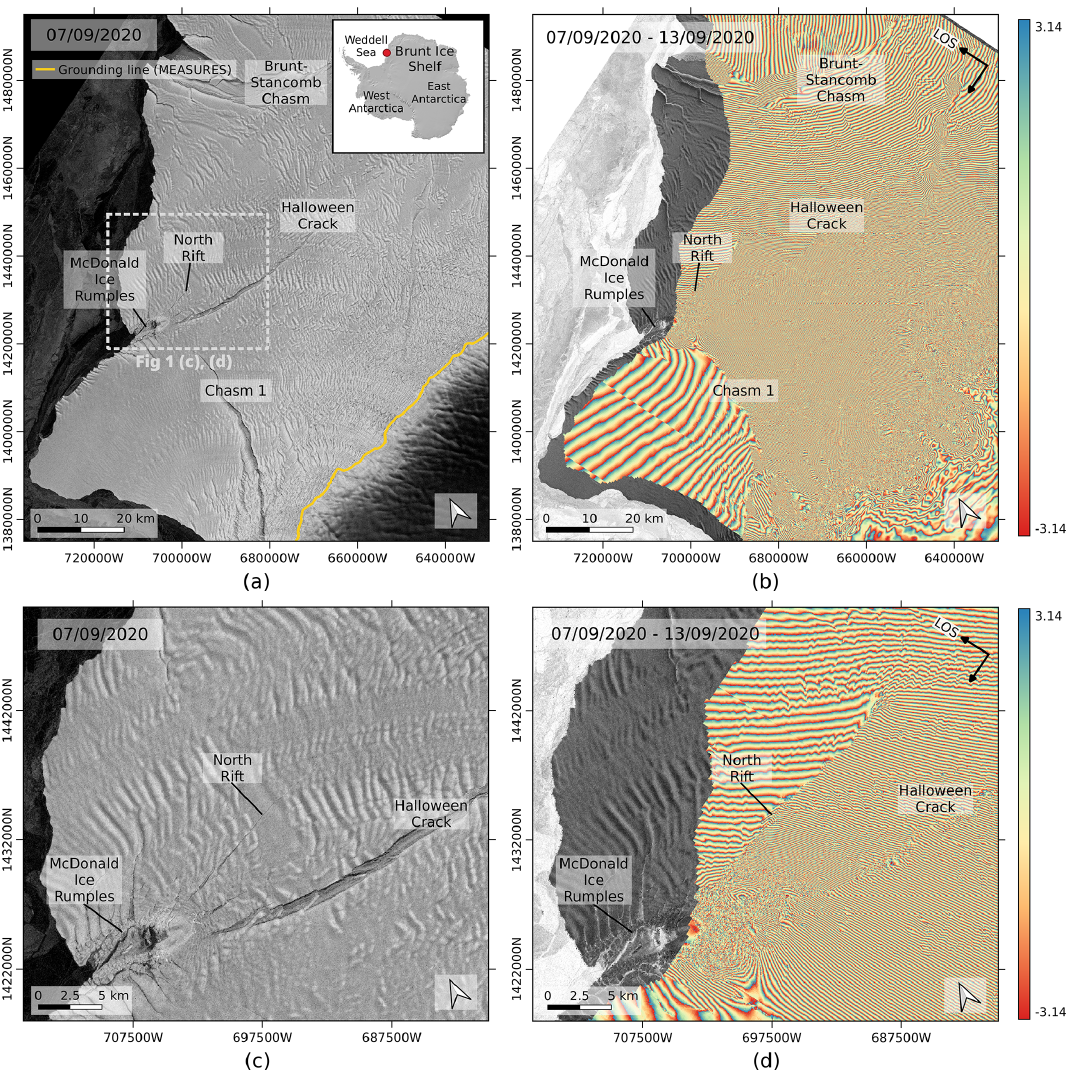
Figure 1. Rifting system on BIS. (a) Sentinel-1 brightness image acquired on 7 September 2020. The inset indicates the location of BIS over the REMA DEM (Howat et al., 2019), and the yellow line indicates the grounding line provided by the MEaSUREs dataset (Rignot et al., 2011, 2014, 2016). (b) Sentinel-1 repeat-pass interferogram of 7–13 September 2020. (c) Close-up of (a) , whose extent is indicated by the grey frame. (d) Close-up of (b)